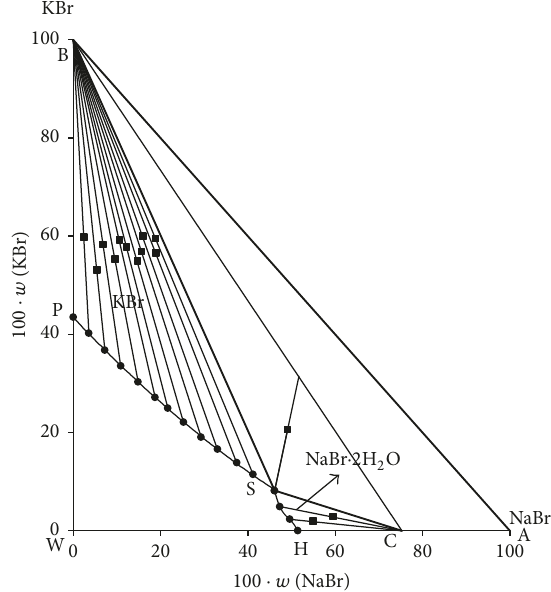
Figure 1: Equilibrium phase diagram of the ternary system NaBr + KBr + H 2 O at 313.15 K. e , equilibrium liquid phase composition; ◼ , moist solid phase composition; A, pure solid of NaBr; B, pure solid of KBr; C, pure solid of NaBr ⋅ 2H 2 O; W, water; H, solubility of NaBr in water; P, solubility of KBr in water; S, cosaturated point of NaBr ⋅ 2H 2 O and KBr.